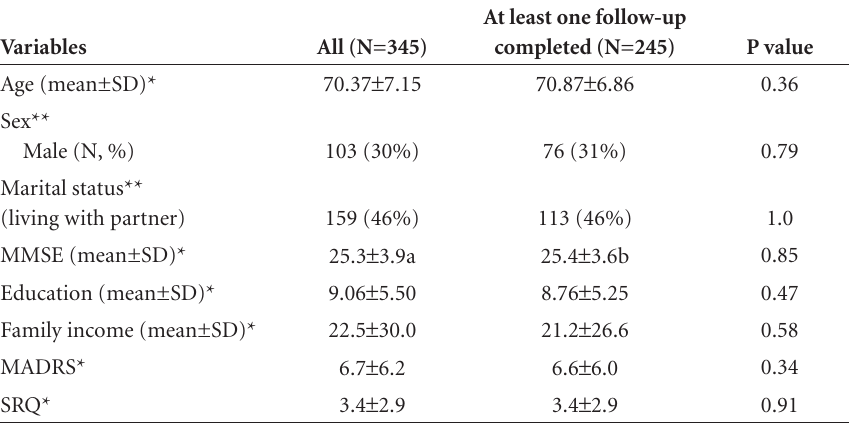
Table 1. Baseline population: age, sex, education, MMSE, family income, SRQ and MADRS at study entry (all and at least one follow-up completed).